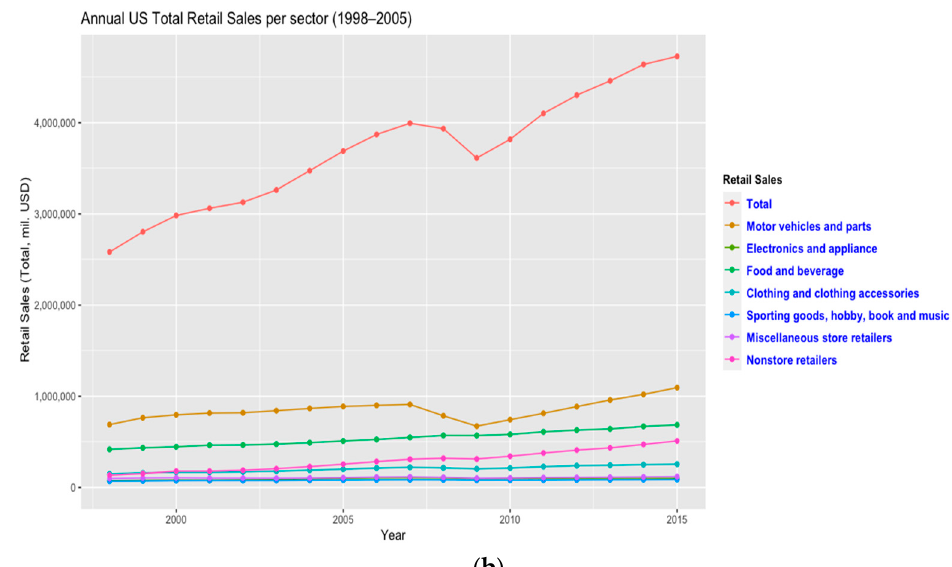
Figure 1. Historical trends and structure of US e-commerce retail sales per sector (panel a ); historical trends and structure of US total retail sales per sector (panel b ).